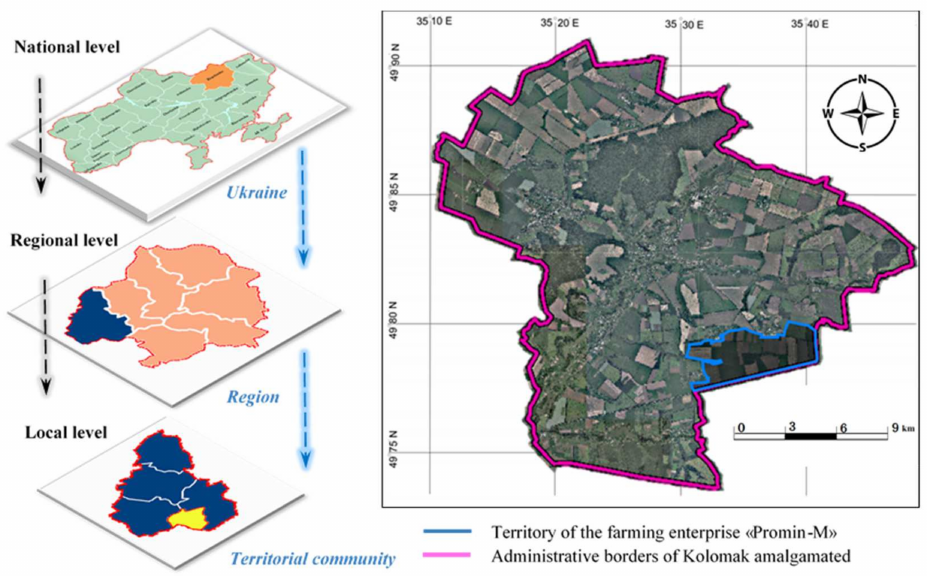
Figure 2. Study area—territory of the farming enterprise “Promin-M” in Kolomak amalgamated territorial community in Bohodukhiv district of Kharkiv region. Basemap source: Open e-Maps